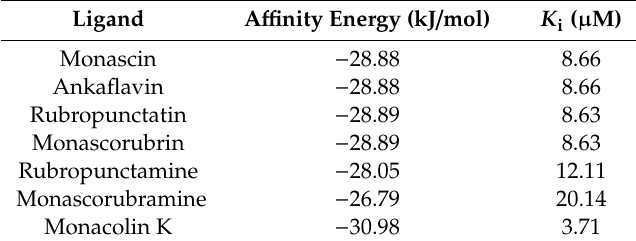
Table 2. Predicted binding energies and computational dissociation constant of Monascus pigments with HMG-CoA reductase (HMGR) (PDB: 1HW9).